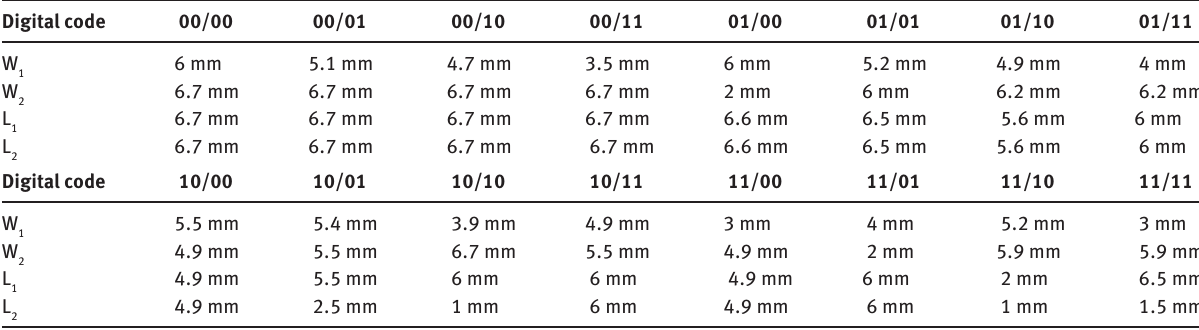
Table 1: The detailed structural parameters corresponding to the 16 frequency-multiplexed 2-bit meta-atoms. Digital code